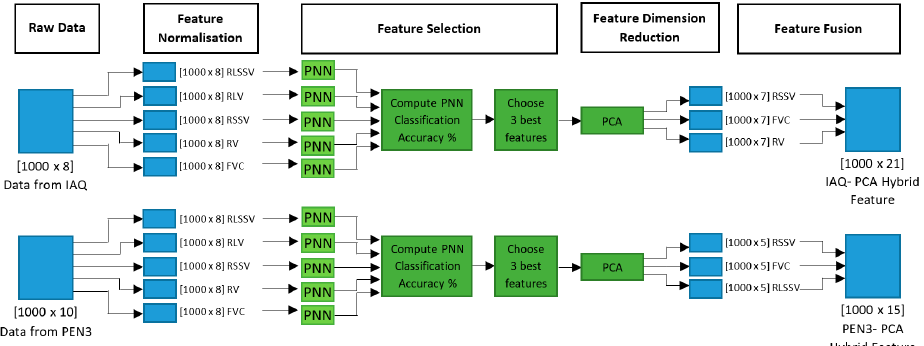
Figure 5. Multi-stage Feature Selection and Fusion Process Flow.